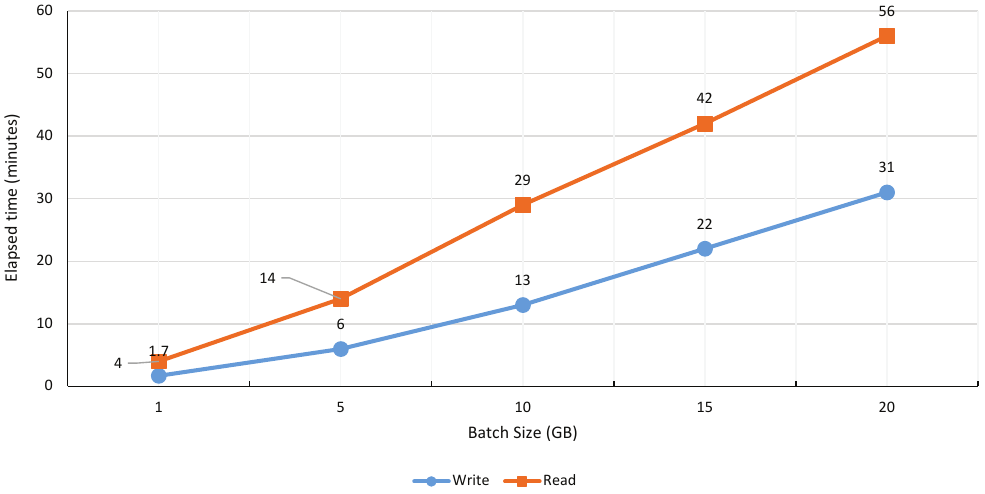
Figure 27. Performance evaluation of Passive Data Reader and Writer.